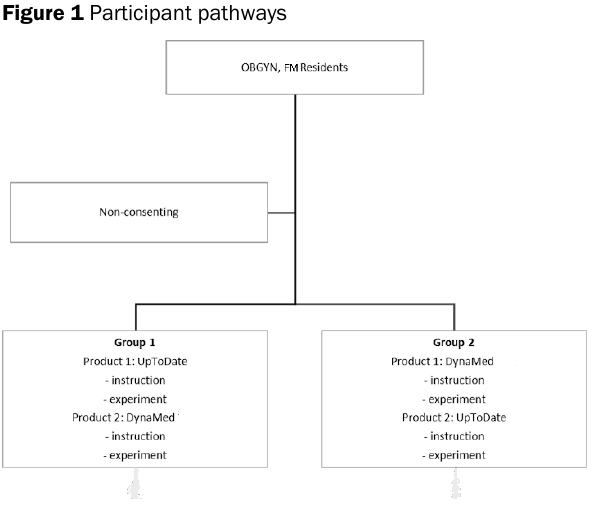
Figure 1 Participant pathways